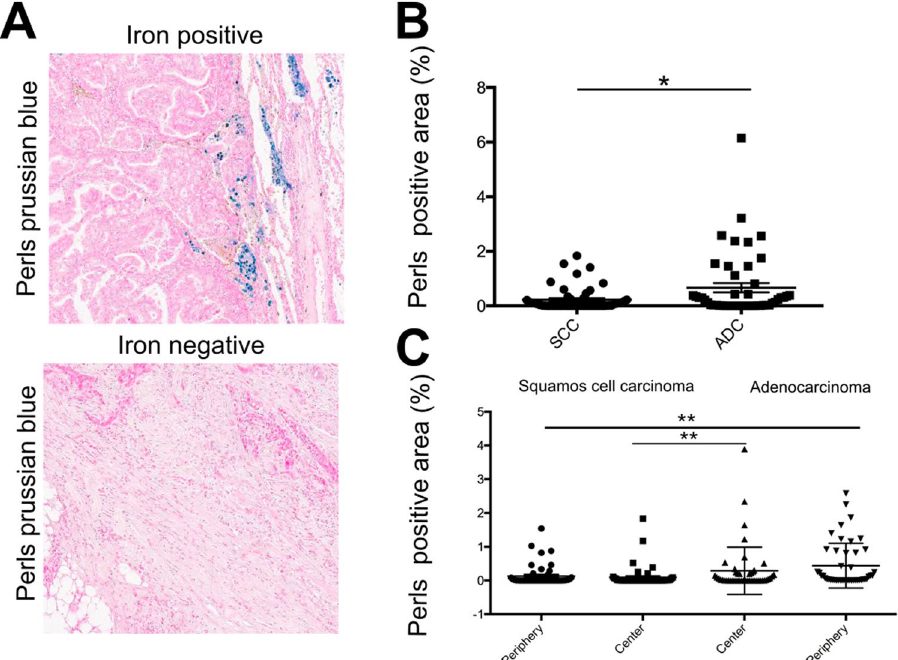
Figure 2. Adenocarcinoma accumulated more iron in the tumor microenvironment than squamous cell carcinoma. ( A ) Example of Perls’ iron staining for an iron positive and an iron negative sample (blue stain represents iron positive areas). ( B ) Comparison of the iron content (tumor center and periphery) in squamous cell carcinoma (SCC) on the left (n = 53) and adenocarcinoma (ADC) on the right (n = 49). ( C ) Comparison of the iron content in the tumor center, and the tumor periphery of ADC (n = 49) and SSC (n = 53), respectively. Perls positive area represents the relative amount (in percent) of iron positive staining. Statistical tests performed are Mann-Whitney U test and Wilcoxon test. Data is shown as mean ± SEM. * p < 0.05, ** p < 0.01, *** p < 0.001, **** p <